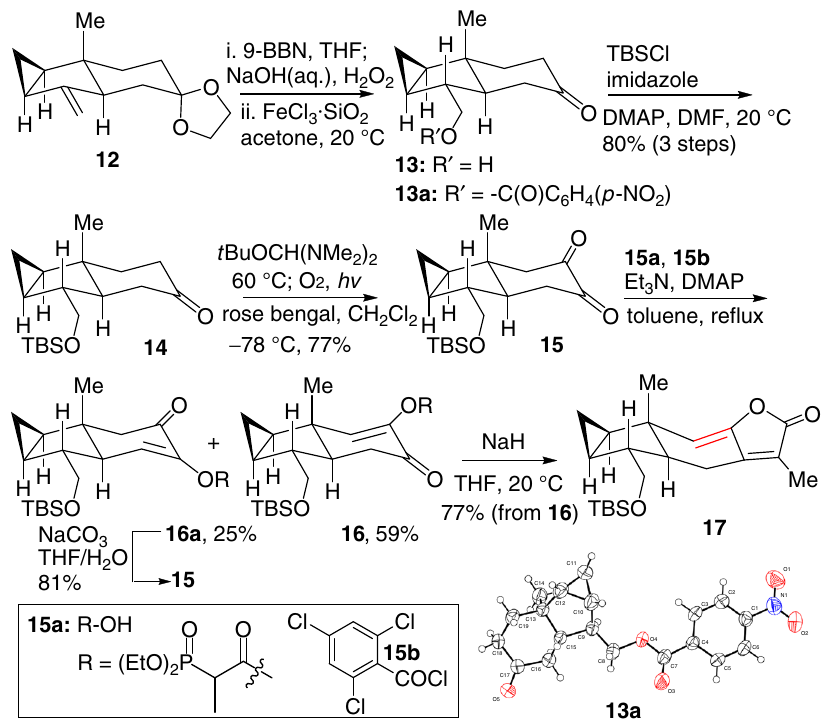
Fig. 4 Synthesis of ethylene 17. 9-BBN 9-borabicyclo[3.3.1]nonane, TBS tert-butyldimethylsilyl, DMAP 4-dimethylaminopyridine, DMP Dess – Martin periodinane